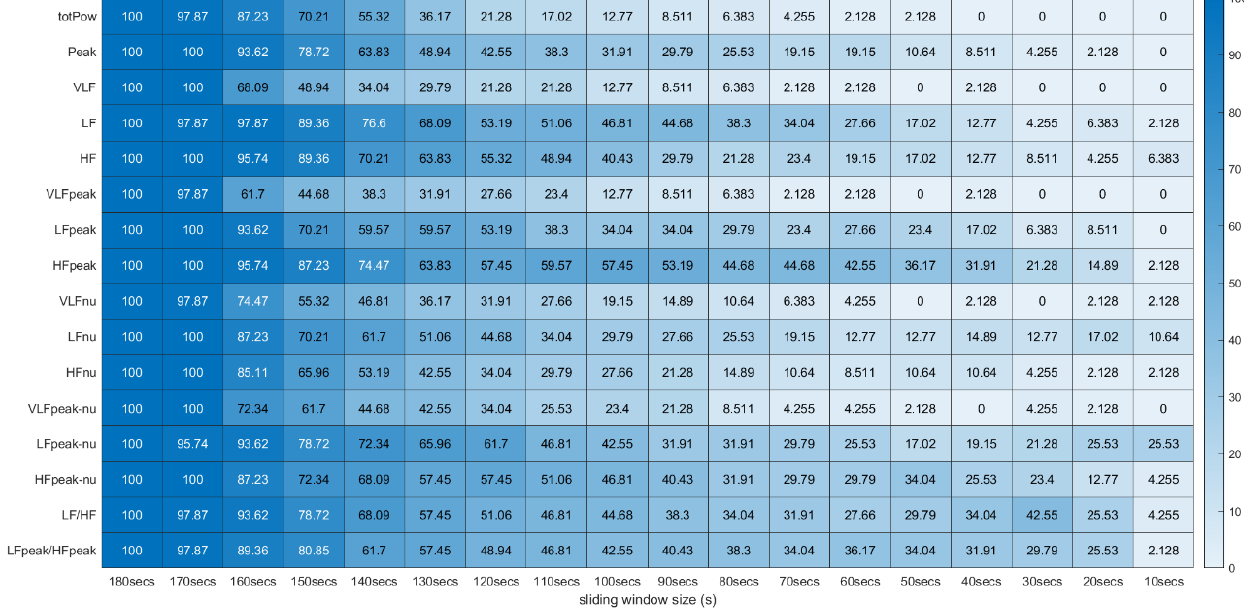
Figure 6. Wilcoxon Rank Sum Test (Frequency Domain) *. * Percentage of runs where the feature (line) extracted with a respective window size (column) did not present significant statistical differences compared to the same feature extracted using the 180-second window.